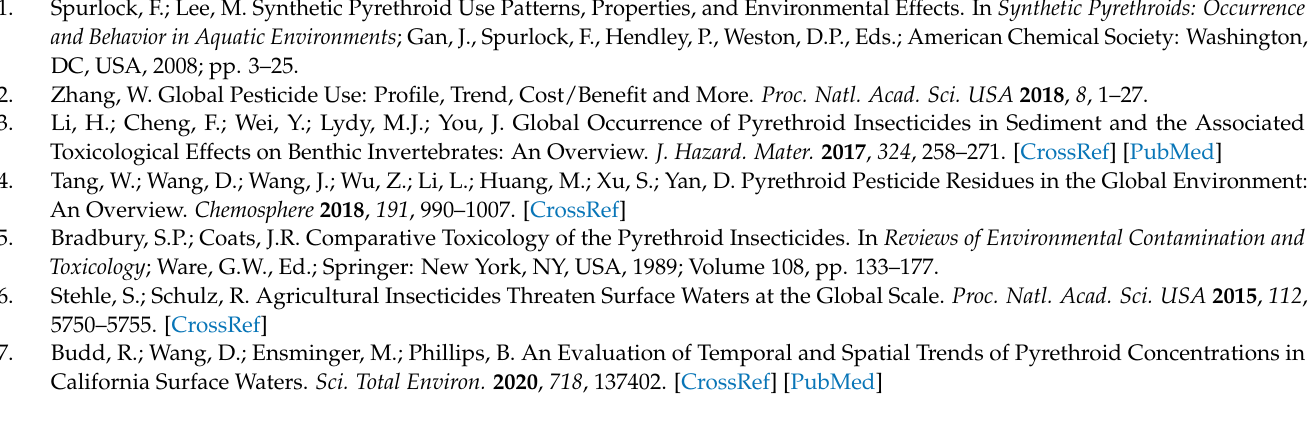
Table S6: Top 20 diseases and functions predicted in Ingenuity Pathway Analysis in rainbow trout exposed to 15 and 30 ng/L